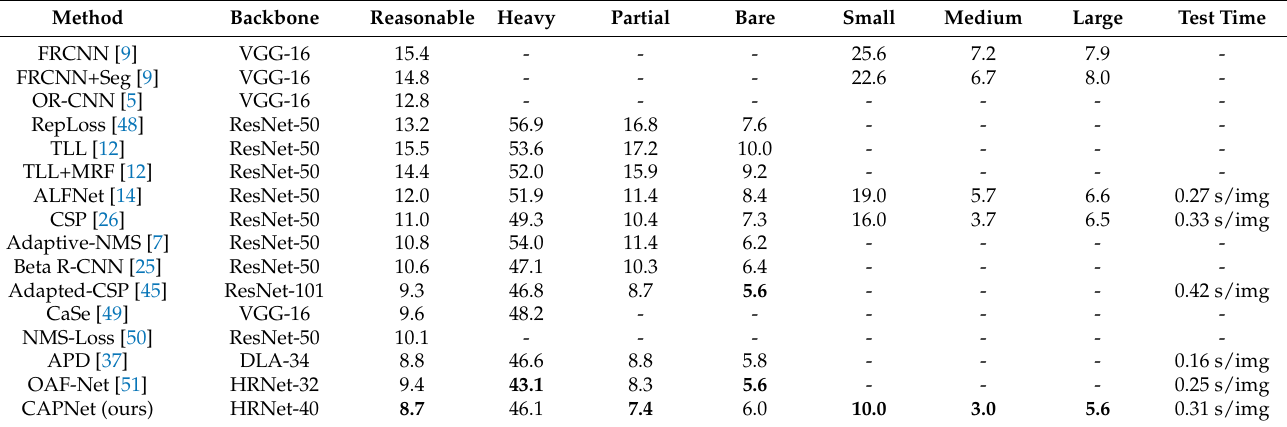
Table 2. The performance comparison between CAPNet and other state-of-the-art methods on each subset of the validation set. The best results are highlighted in